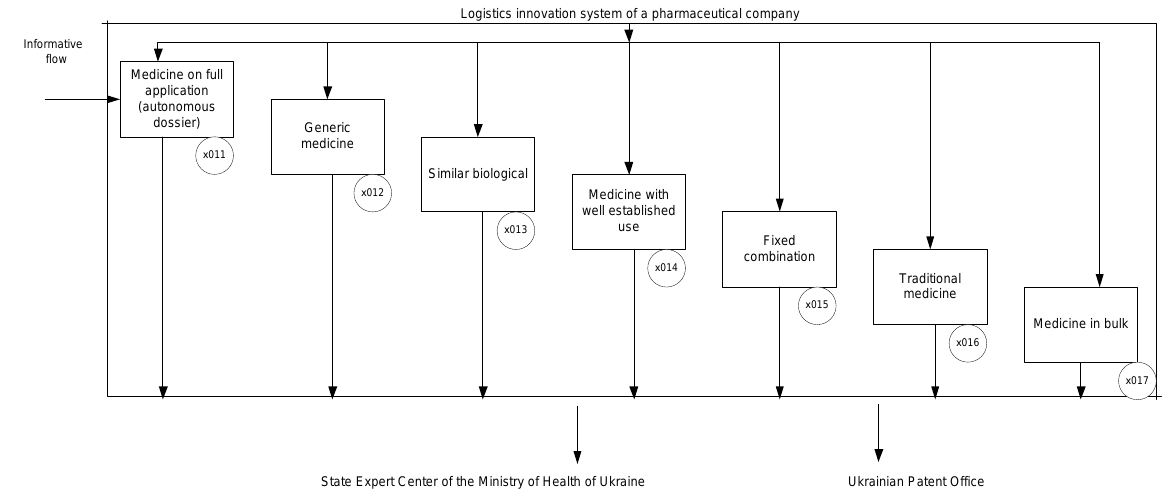
Fig. 3 Detailing of the information flow in the logistics innovation system of pharmaceutical